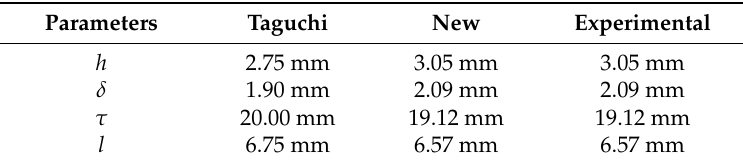
Table 10. Comparison of structural parameters.